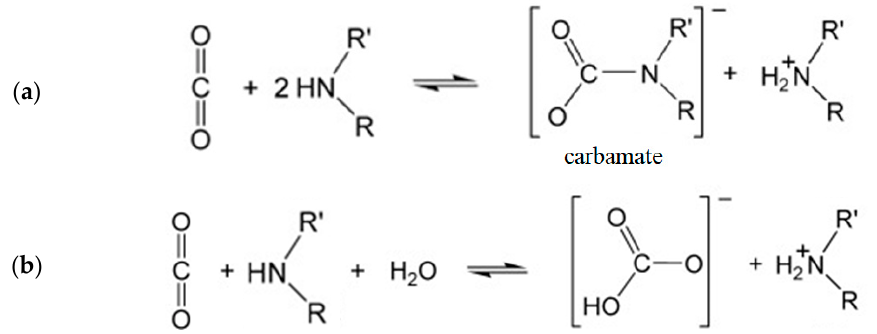
Figure 4. Three classes of amine-modified sorbents.